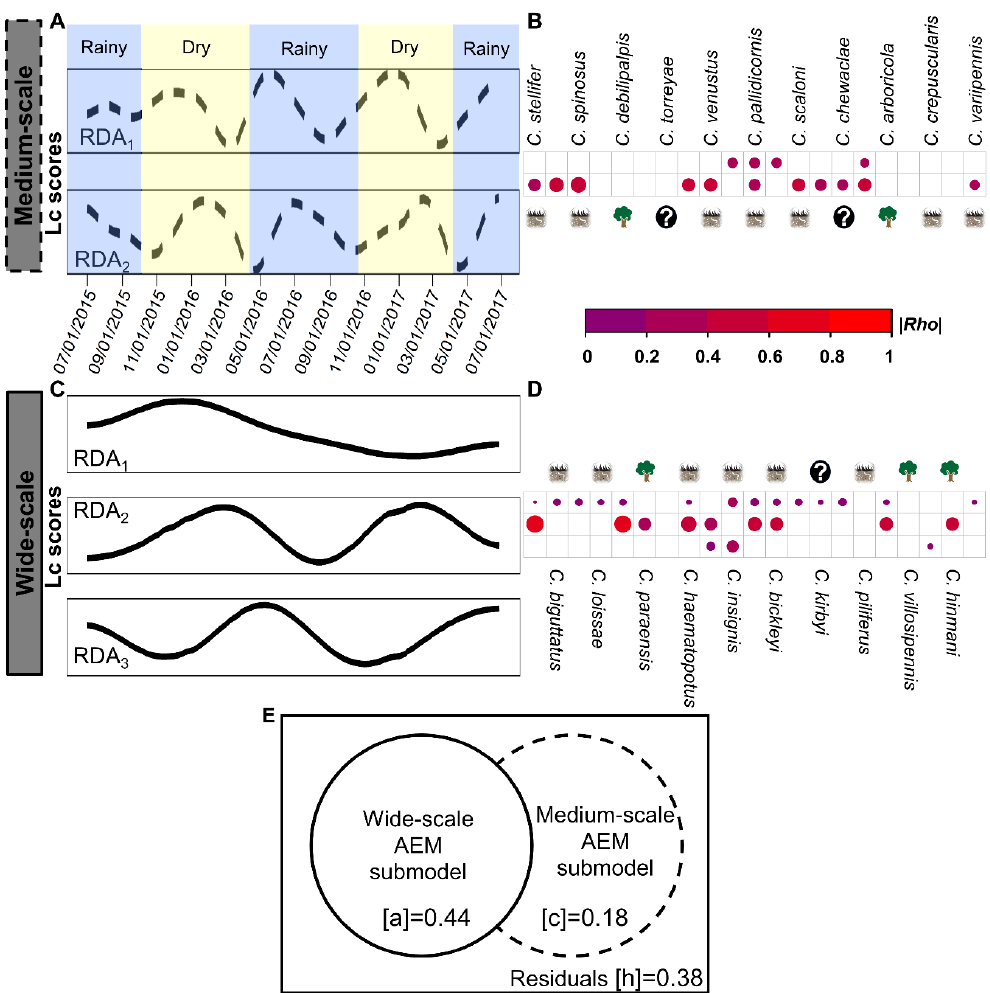
Figure 2. Temporal scales behind Culicoides assembling pattern: the changes in species composition followed annual and biannual temporal profiles. ( A , C ) Panels describe the weekly oscillation in the community composition by each significant AEM temporal submodel and the nonoverlapping structures within them. Table S1.1 summarizes temporal scales and their week range, AEMs and statistical significance. The x-axis is shared between panels ( A , C ). Panel A also shows the rainy (light blue) and dry (light yellow) seasons in Florida. ( B , D ) Panels indicate compromised species for the changing composition at each temporal profile (RDA) after Spearman rank correlation. Only significant | Rho | showed where size and color followed the magnitude of the species-temporal structure association (Table S1.2). Larval habitat traits are indicated as wet soils and tree holes with shapes. The question mark indicates those species where the larval habitat was not described. Panel ( E ): Venn diagram represents the amount of variation in the community change composition at each temporal scale by hierarchical variance partitioning. Fractions were described in Culicoides β -diversity temporal profile section and their R 2 adj